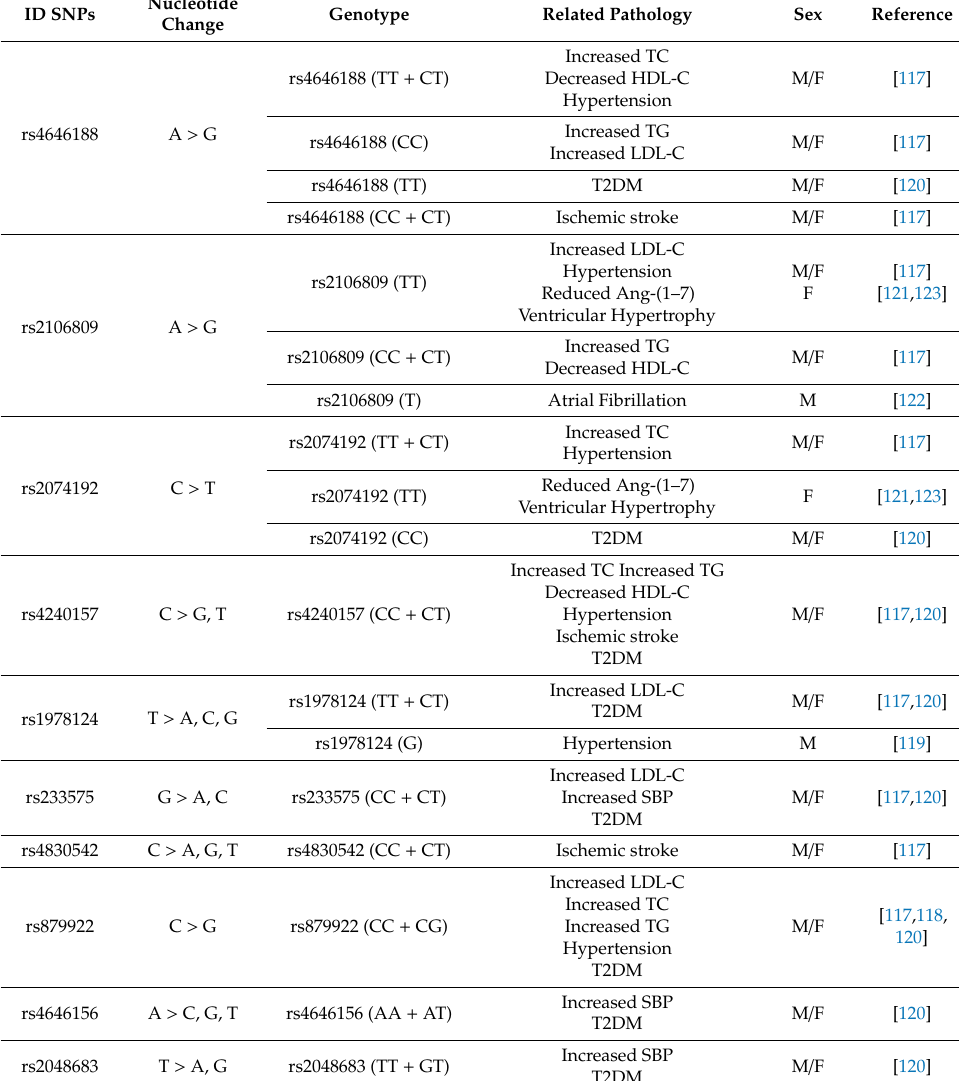
Table 1. ACE2 variants and related CV alterations. Specific SNPs of ACE2 can associate with abnormalities in lipid profile (total cholesterol (TC), high-density lipoprotein-cholesterol (HDL-C), low-density lipoprotein-cholesterol (LDL-C), or triglycerides (TG)), in blood pressure (hypertension or elevation of systolic blood pressure (SBP)) and CV injury (ischemic stroke, ventricular hypertrophy, or atrial fibrillation), and / or T2DM. Other variants have also correlated with decreased levels of plasma Ang-(1–7) (rs2106809 and rs2074192). All these alterations may worsen COVID-19 evolution. A, G,